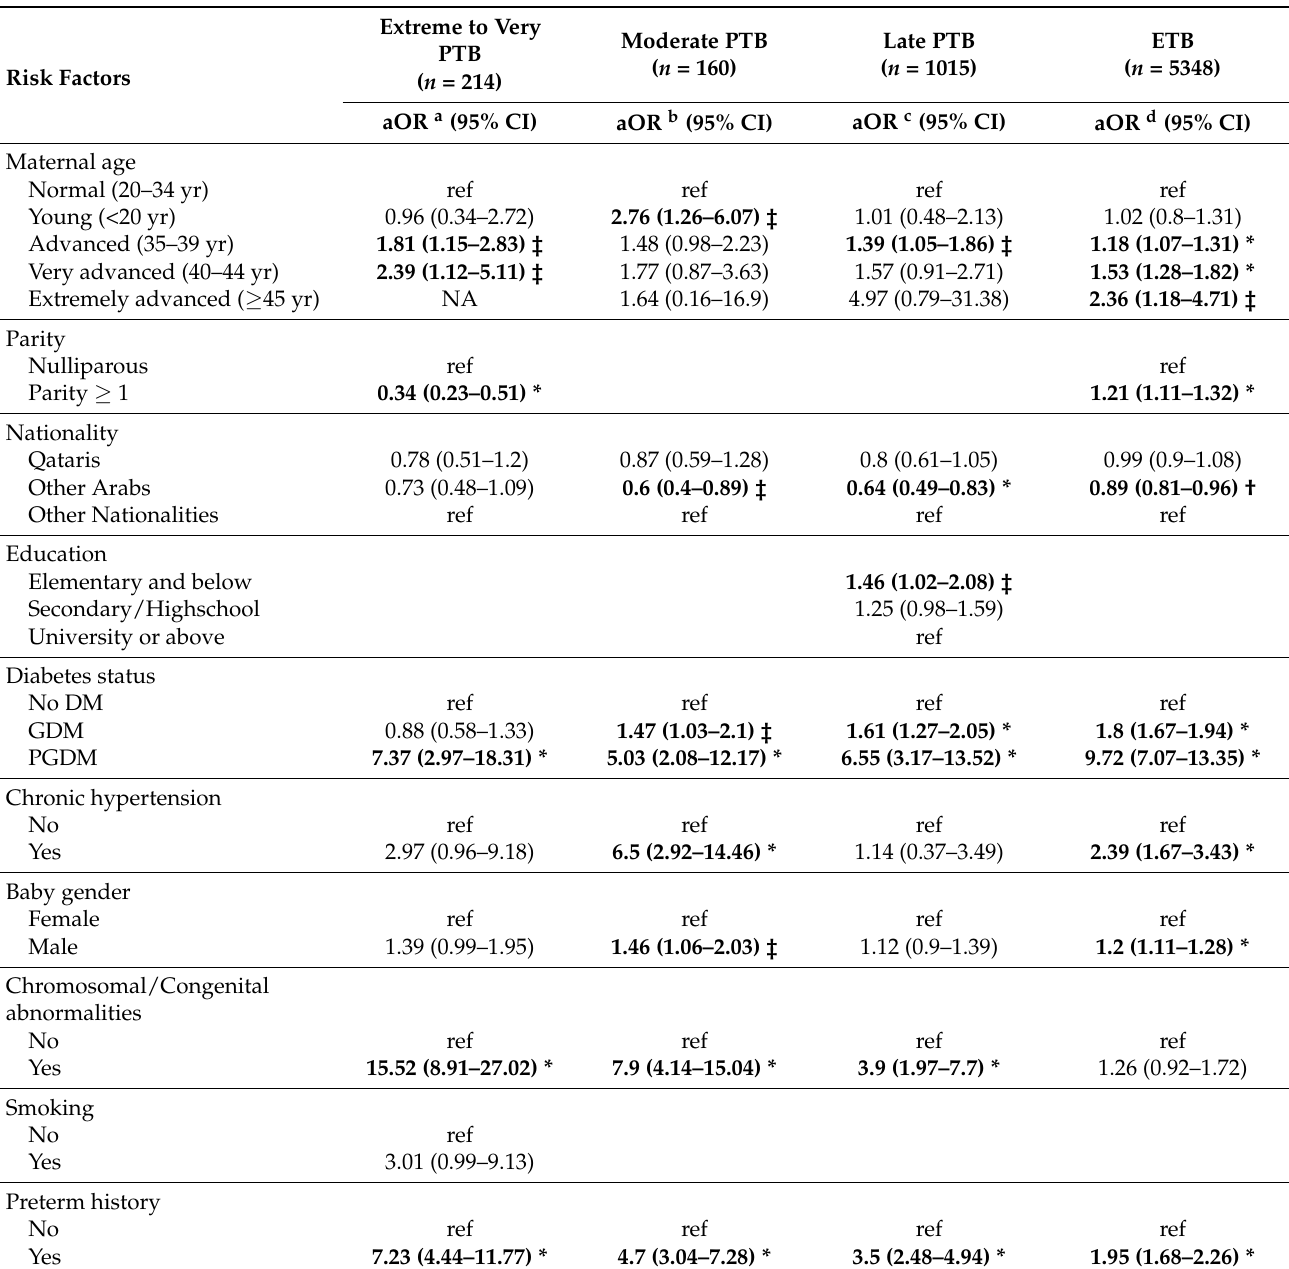
Table 2. Multivariate regression analyses of the risk factors associated with PTB and